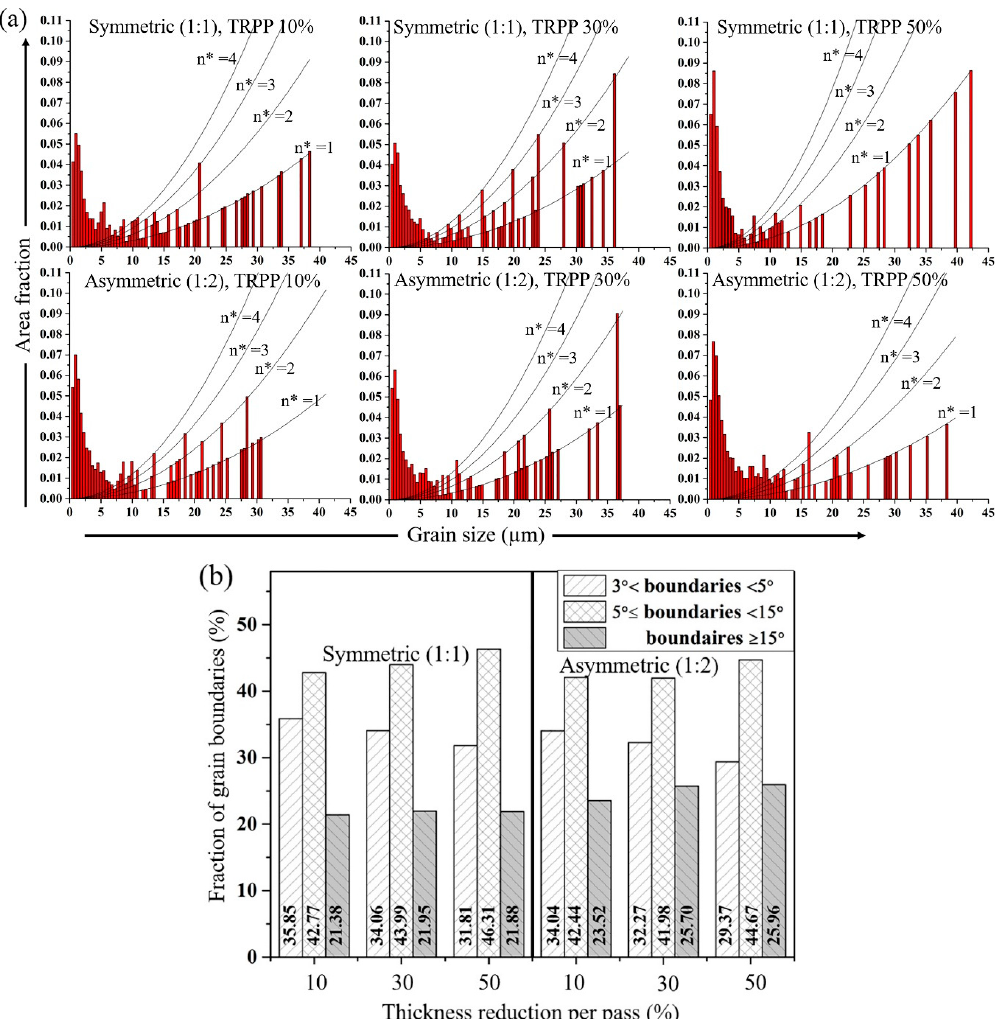
Figure 10. ( a ) Grain size distributions (area fractions) and ( b ) fraction of grain boundaries for symmetric and asymmetric (1:2) rolling in medium strain (75%) for TRPP of 10, 30, and 50%. The added parabolas indicate the number of large grains being in the same bins (n*).